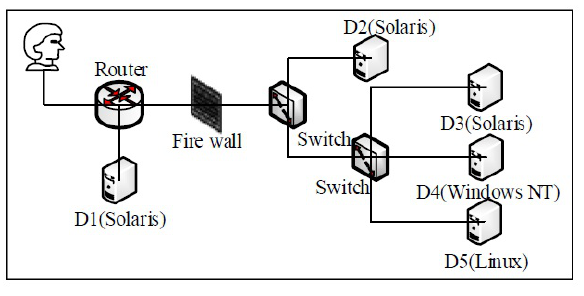
Fig. 3 Network scenario